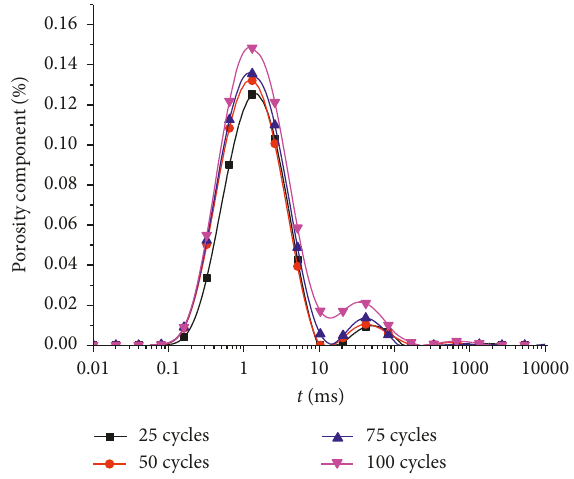
Figure 4: NMR T 2 spectrum distribution during freeze-thaw